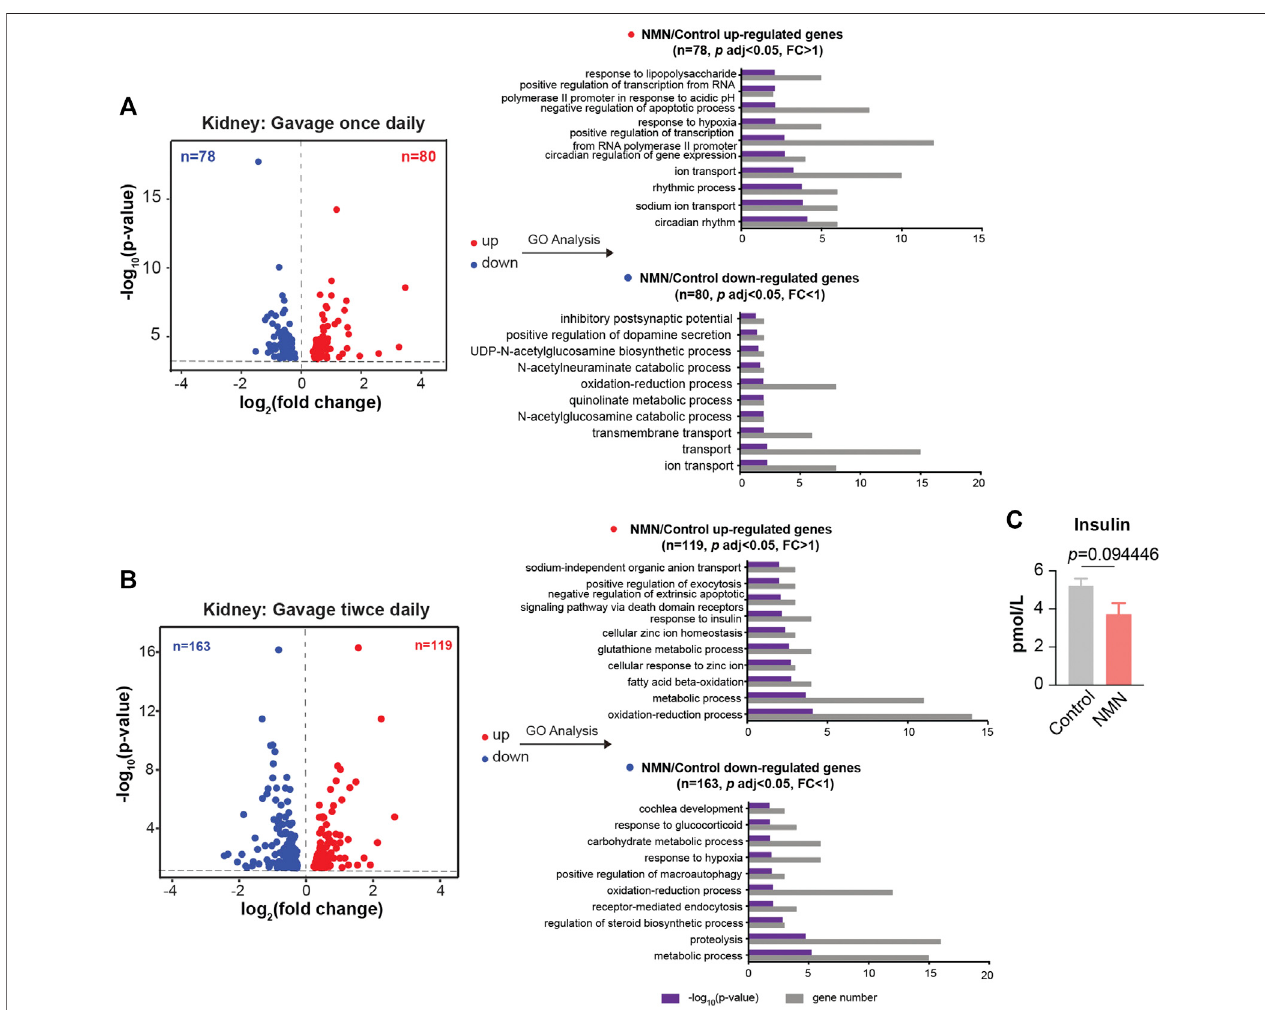
FIGURE 6 | Transcriptomic Analysis in NMN Administrated Mice Kidney. (A) Volcano plot shows that genes are differentially expressed in 1340 mg/kg/d NMN- administrated mice compared tocontrol in kidney (left panel) . Differential expression analysis was performed by DESeq2 from four biological replicates.80 genes were found to be upregulated ( p < 0.05, FC > 1), 79 genes were down regulated ( p < 0.05, FC > 1). Gene ontology (GO) analysis were performed by David (right panel) . (B) . Volcano plot shows that genes are differentially expressed in 2680 mg/kg/d NMN-administrated mice compared to control in kidney (left panel) . Differential expression analysis was performed by DESeq2 from three biological replicates. 119 genes were found to be upregulated ( p < 0.05, FC > 1), 163 genes were down regulated( p < 0.05,FC < 1).Geneontology(GO)analysiswereperformedbyDavid (right panel) .Geneontology(GO)analysis(performedbyDavid)showsresponseto